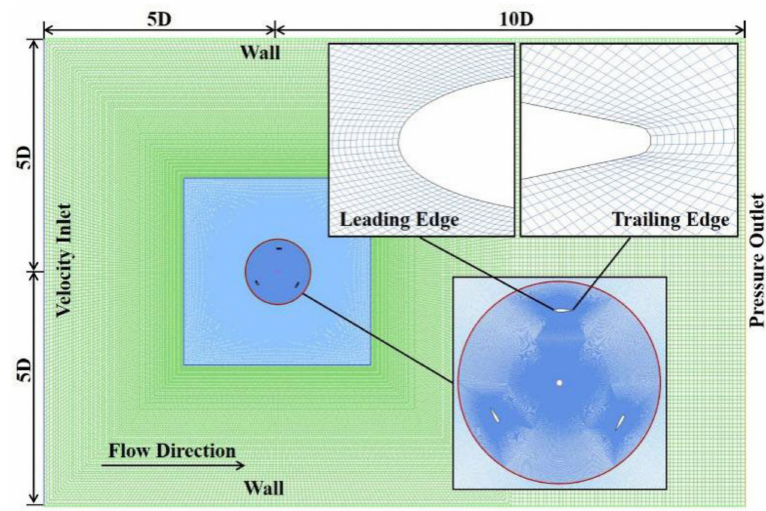
Figure 2. Computational domain and mesh structures of a stand-alone